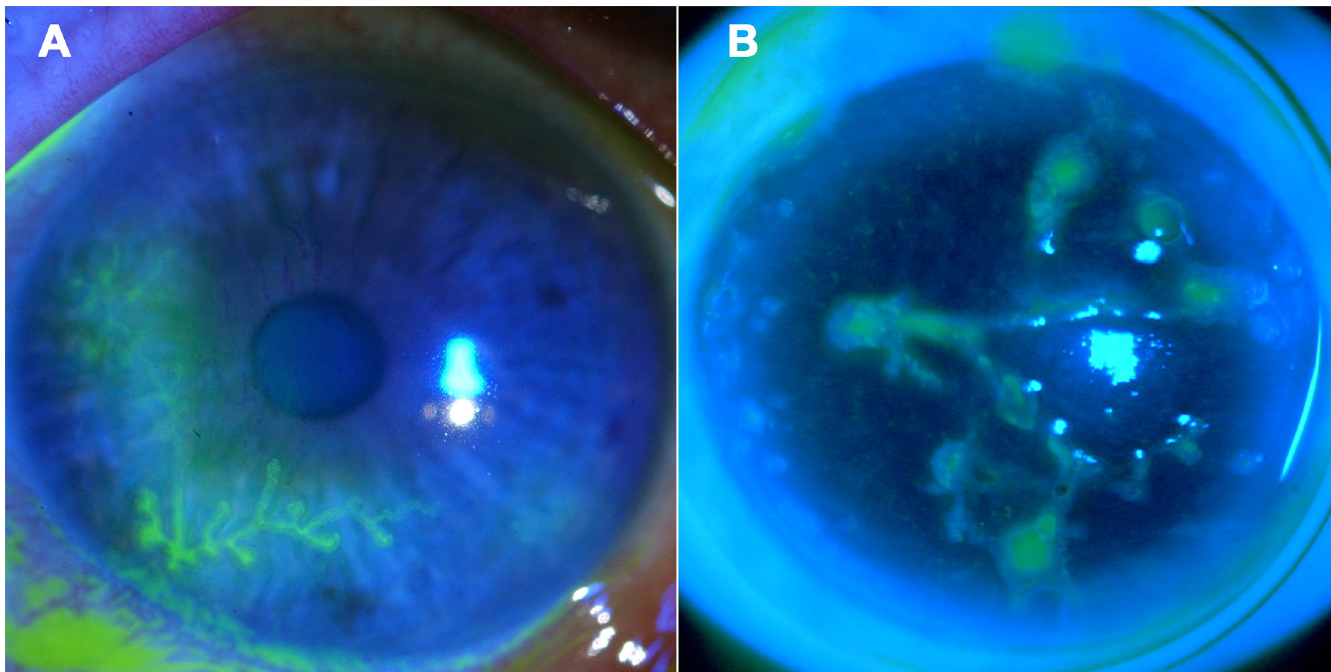
Fig 2. Observation with a slit lamp and cobalt blue filter of dendritic herpetic keratitis in a patient (A, personal database of GT) and of a dendritic epithelial lesion obtained in the ASM at day 4 post infection (B).